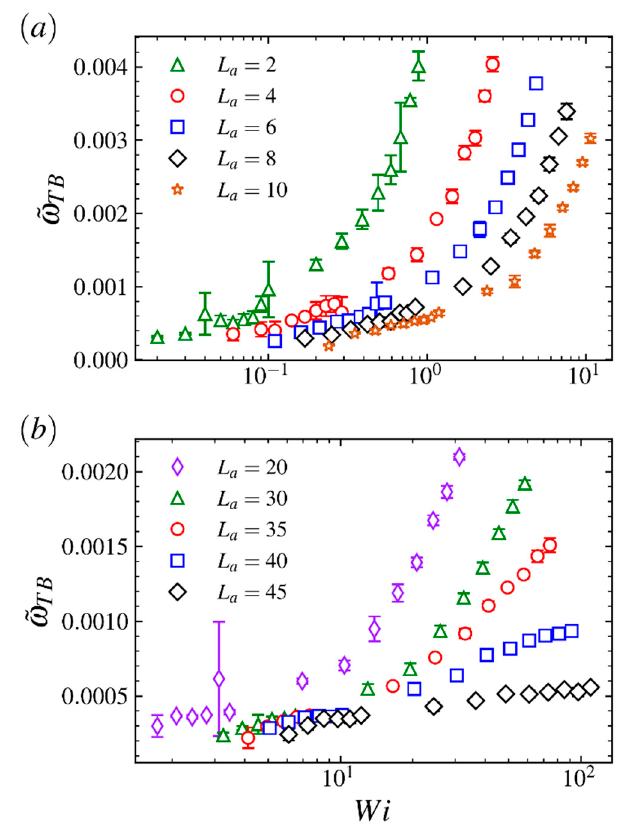
Figure 8. The characteristic tumbling frequency (cid:101) ω TB as a function of the Weissenberg number Wi for comb polymers with ( a ) long arms and ( b ) short arms.